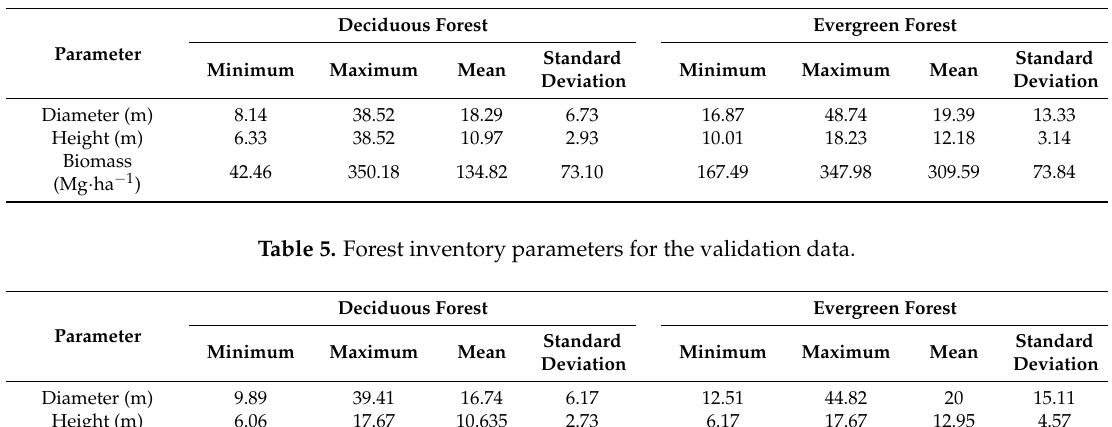
Table 4. Forest inventory parameters for the training data.